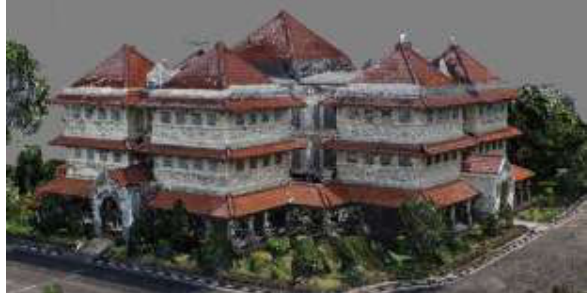
Figure 5. Dense Point Cloud of Library Building from aerial